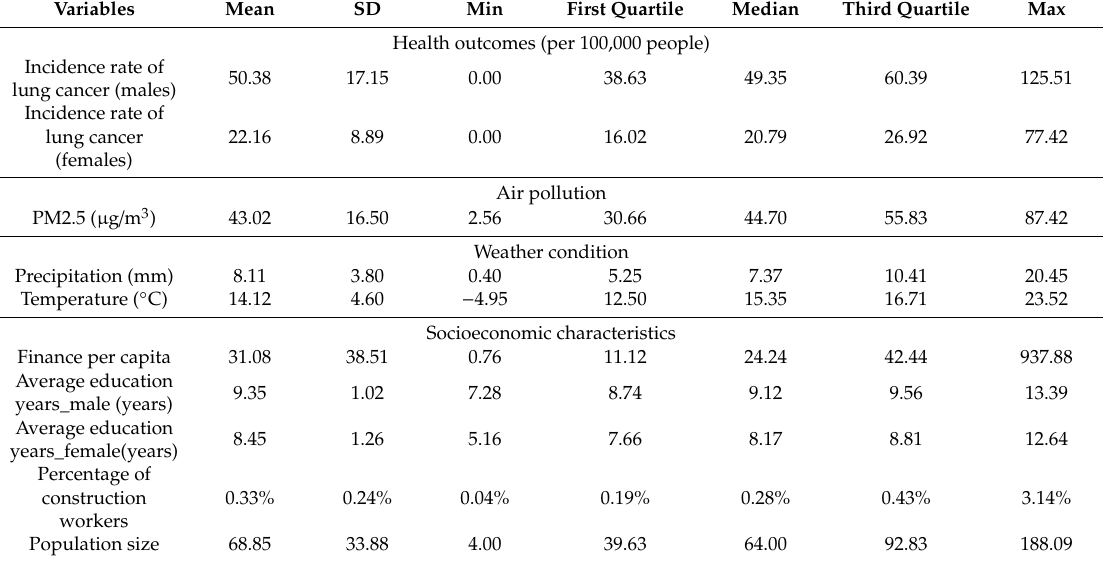
Table 1. Descriptive statistics of health outcomes, air pollution, weather and socioeconomic